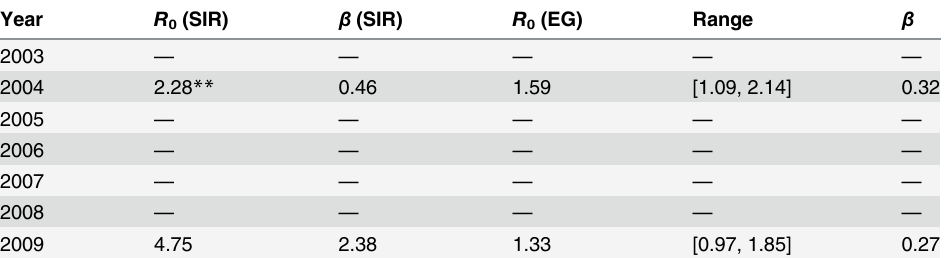
Table 5. Second outbreak of RSV. The t -test statistically significant p < 0.05 is marked with ** . Year R 0 (SIR) β (SIR) R 0 (EG) Range β 2003